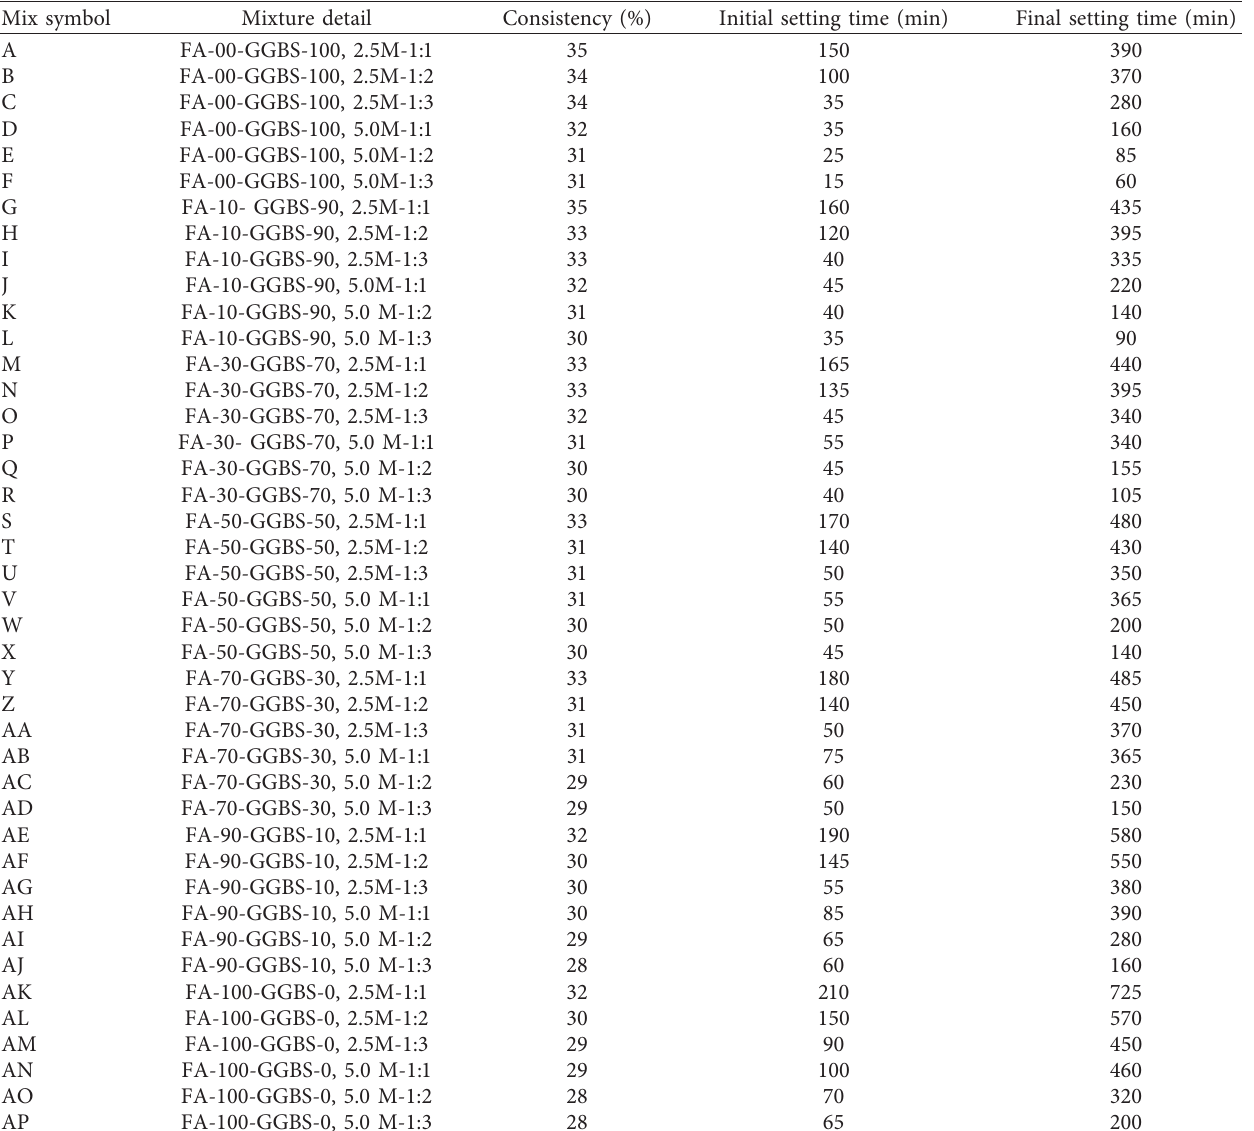
Table 2: Percentage of consistency and setting times of blended geopolymer